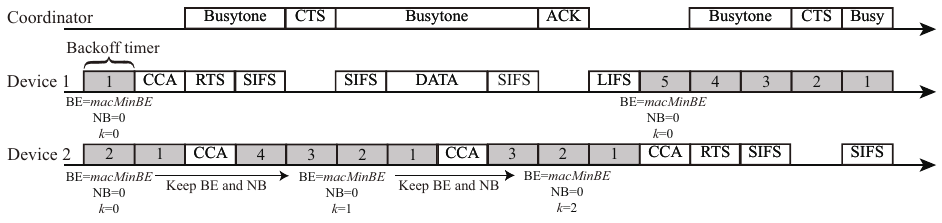
Figure 6. Channel access example of the proposed